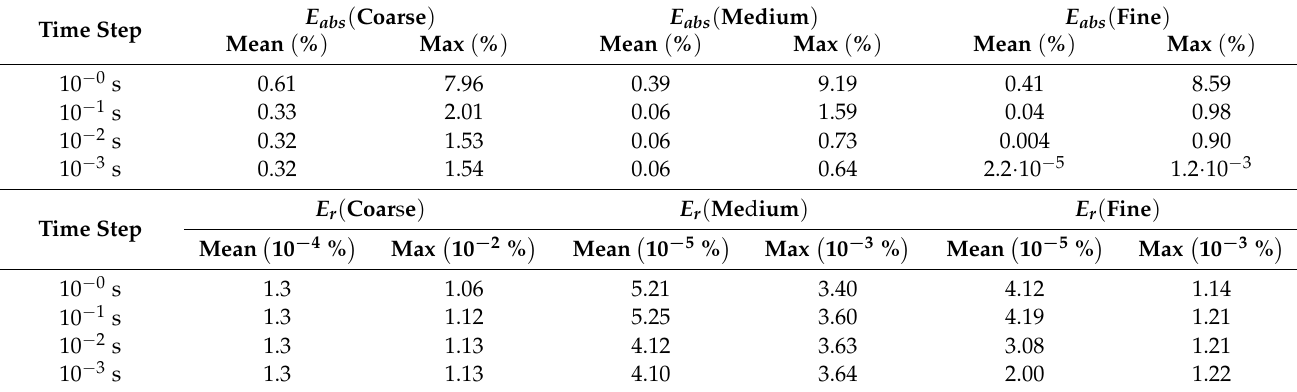
Figure 5. Grid induced error evolution. Table 2. Maximum and Mean Values of the Absolute and Relative Errors for the Diffusion